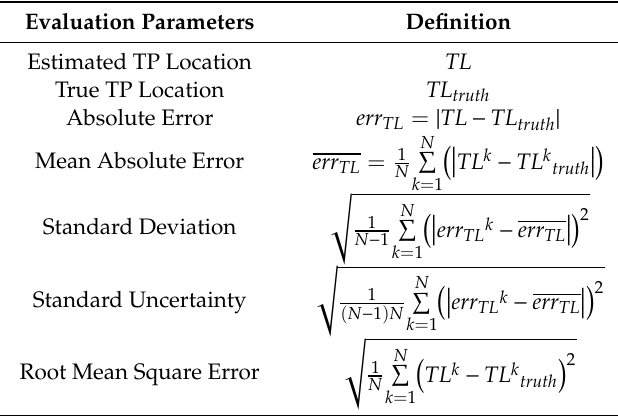
Table 2. Definition of evaluation